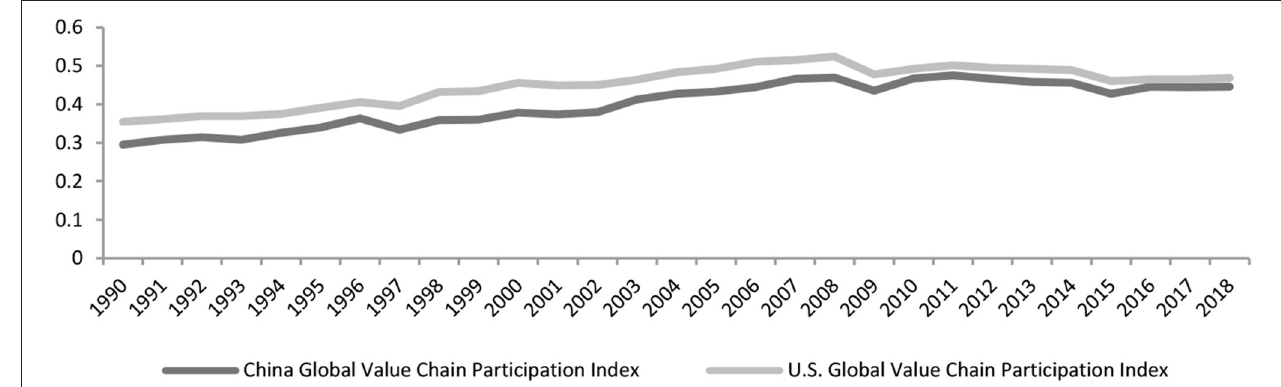
FIGURE 7 | China and U.S. Global value chain participation index. Data source: UNCTAD-Eora GVC.